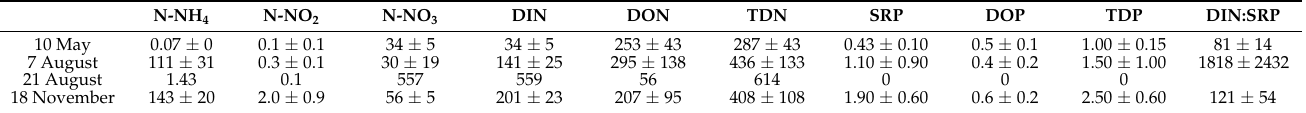
Table 2. Means ( ± SD) of nutrient variables expressed in µ M, DIN:SRP molar ratio, among water samples collected monthly at six stations arranged in a central transect along the length of the basin, and values of one sample collected on 21 August, in the western ditch (wd, Figure 4). Ammonia nitrogen, N-NH 4 ; nitrous nitrogen, N-NO 2 ; nitrate nitrogen, N-NO 3 ; dissolved inorganic nitrogen, DIN; dissolved organic nitrogen, DON; total dissolved nitrogen, TDN; soluble reactive phosphorus, SRP; dissolved organic phosphorus, DOP; total dissolved phosphorus,